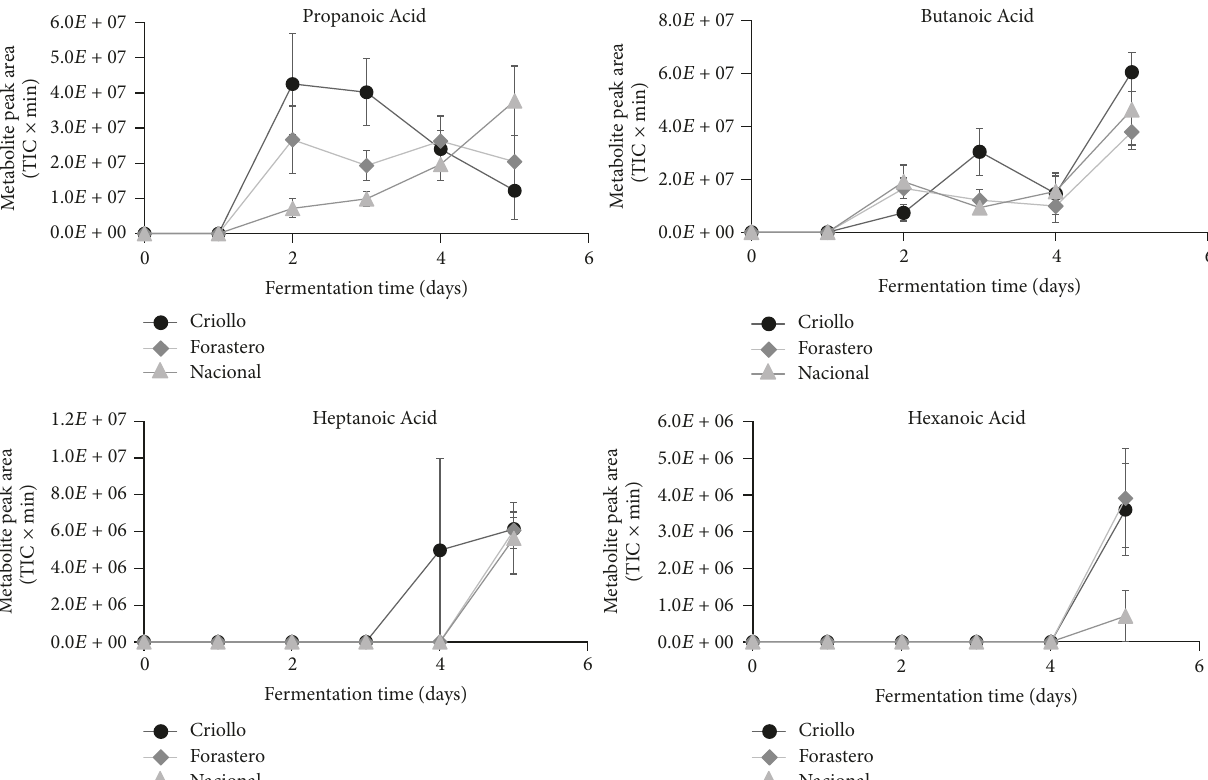
Figure3:LevelsofsignificantorganicacidsinCriollo,Nacional,andForasterobeansatdifferentfermentationtimes.Levelsofeachmetabolite are presented as peak area (total ion current times the differential retention time for each metabolite in